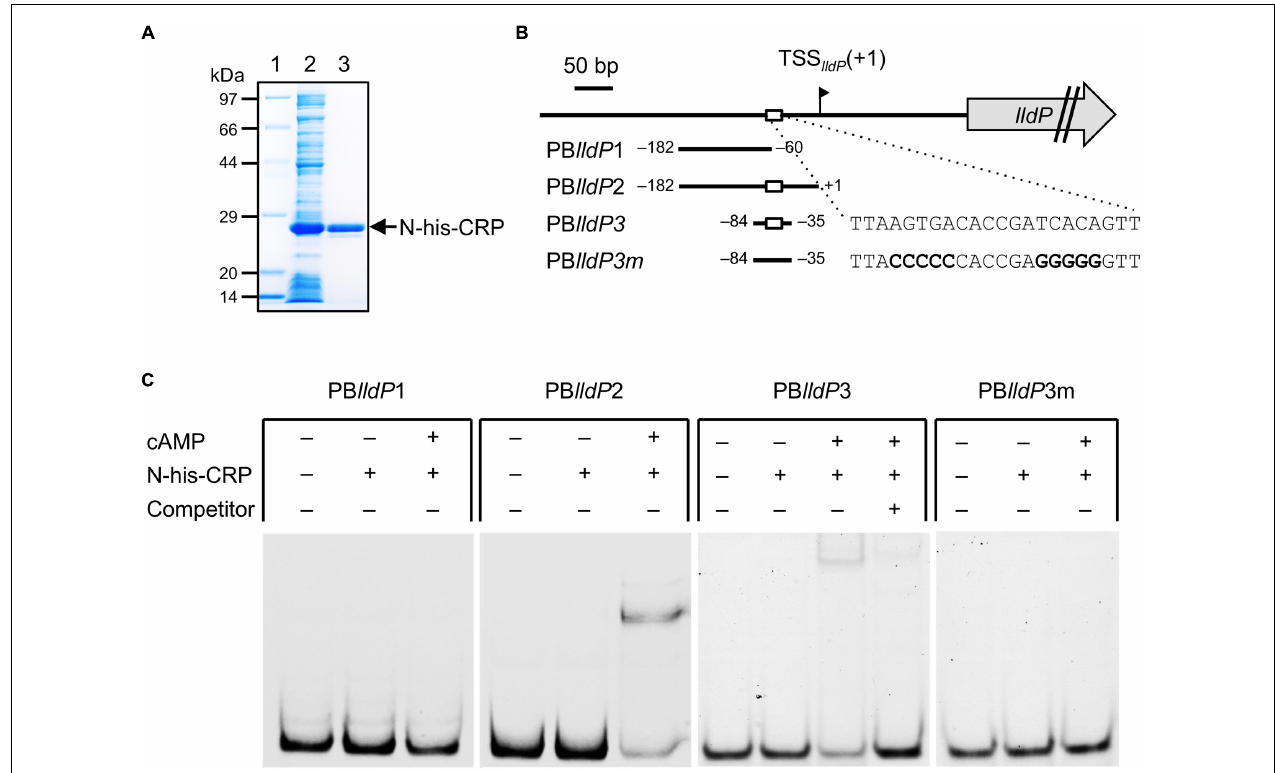
FIGURE 9 | Electrophoretic mobility shift assay (EMSA) using CRP and upstream regions of lldP . (A) Sodium dodecyl sulfate–polyacrylamide gel electrophoresis (SDS–PAGE) of N-his-CRP protein samples. Protein samples (5 µ g) were analyzed on 12.5% SDS-polyacrylamide gels. Lane 1, Escherichia coli BL21 (DE3) (pET-crp) crude extract; lane 2, purified N-his-CRP; lane 3, molecular weight marker. (B) DNA fragments used as probes. Positions of 5 (cid:48) and 3 (cid:48) ends of the fragments relative to TSS lldP (+1) are shown. White boxes represent the putative CRP-binding motif. The mutated sequences in PB lldP 3m are shown in bold. (C) Binding of CRP to each probe. DNA-binding reactions were performed in the presence (+) or absence (–) of CRP, cAMP, and specific competitor (2 µ M unlabeled PB lldP 3